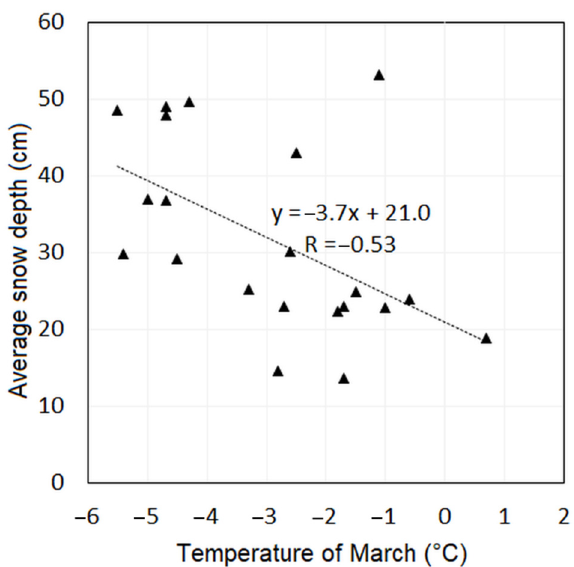
Figure 6. Correlation between the temperatures of March and average snow depth measured at the Skalnaté Pleso Observatory (1778 m a.s.l.) in the period 2000–2020. The correlation is signifi- cant with R = − 0.53 and shows a decreasing average snow depth with increasing temperature in